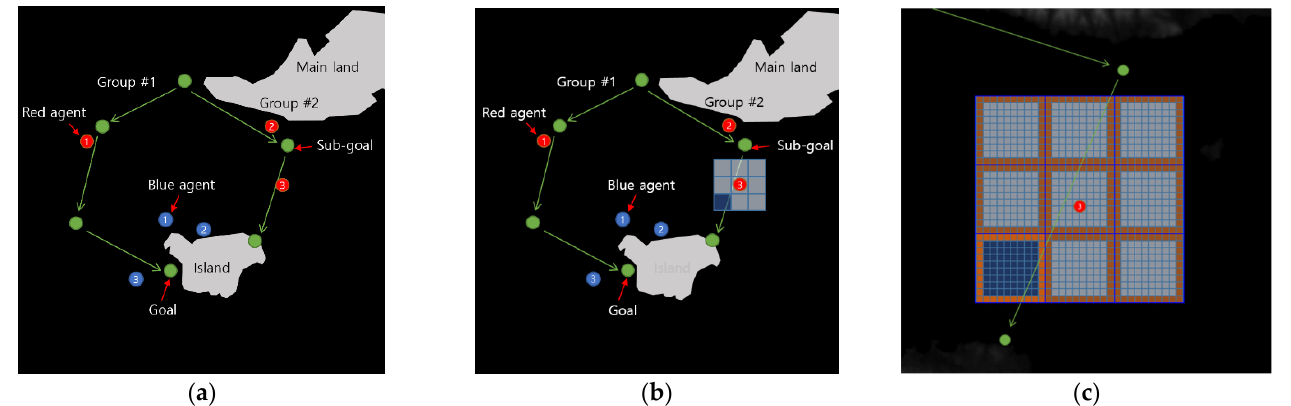
Figure 1. Double layered A3C architecture: ( a ) sub-goal settings, ( b ) upper layer, and ( c ) lower layer.